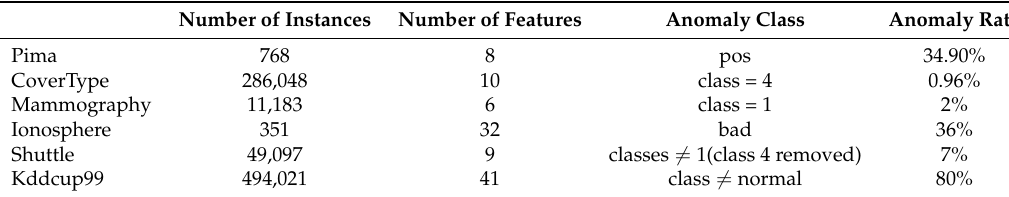
Table 2. Characteristics of the six classic